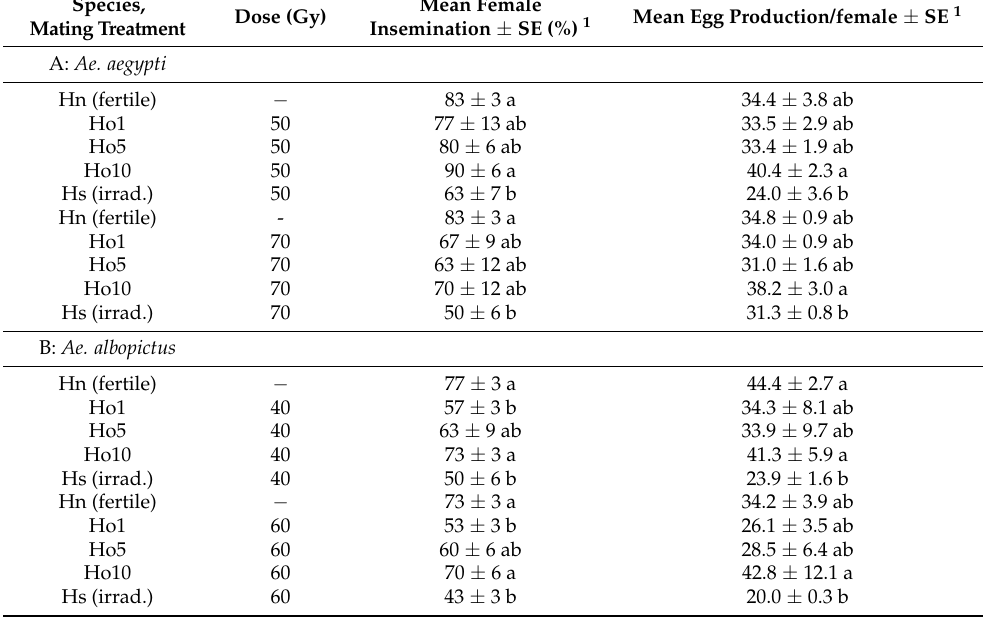
Table 1. Prevalence (%) of insemination of (A) Aedes aegypti and (B) Aedes albopictus females in laboratory cages subjected to different mating treatments and egg production in mated females. Males were irradiated in the pupal stage with one of two irradiation doses or were fertile controls. Species, Mean Female Dose (Gy) Mean Egg Production/female ± SE Mating Treatment Insemination ± SE (%) 1